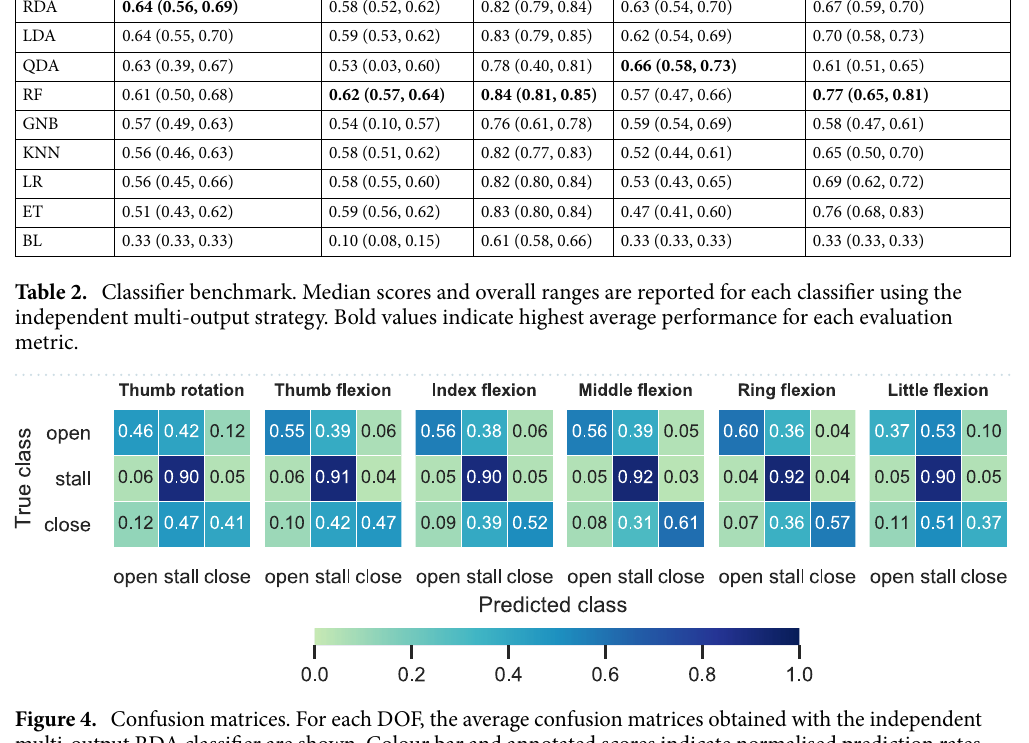
Figure 3b summarises the results of the classifier benchmark analysis using independent output classifiers. The highest median performance was achieved by regularised discriminant analysis (RDA) ( F 1 med = 0.64 ), closely followed by LDA. We performed statistical comparisons between the highest-performing algorithm (i.e., RDA) and all other classifiers and found that RDA significantly outperformed all classifiers except LDA. All classifiers performed higher than chance. A performance summary with all evaluation metrics is presented in Table 2. Figure 4 shows average confusion matrices obtained with the independent multi-output RDA classifier for